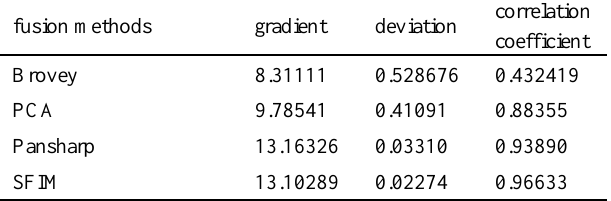
Table 1 Assessment results of ZY03 fused